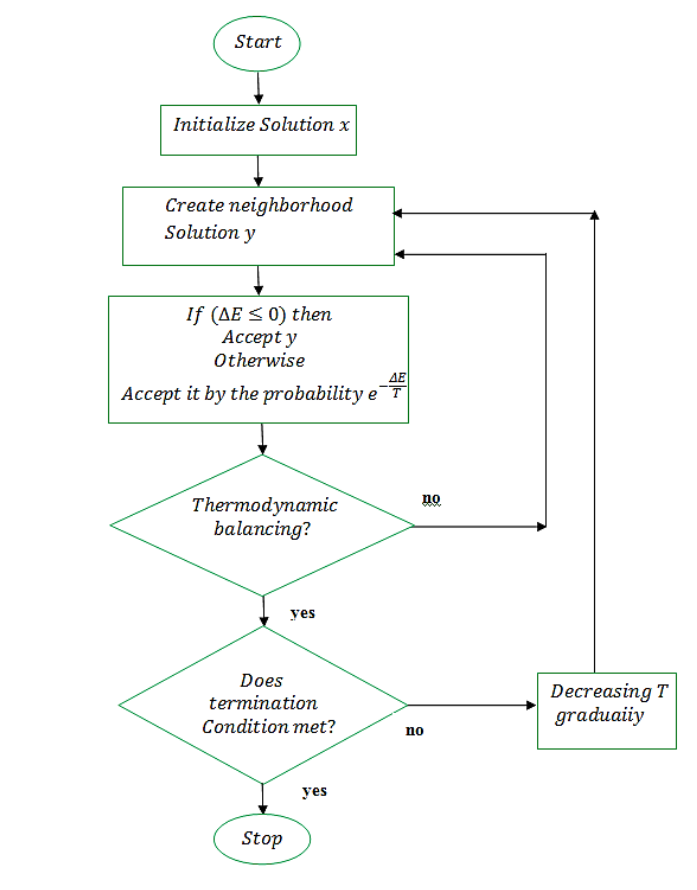
Figure 1. Simulated Annealing flowchart